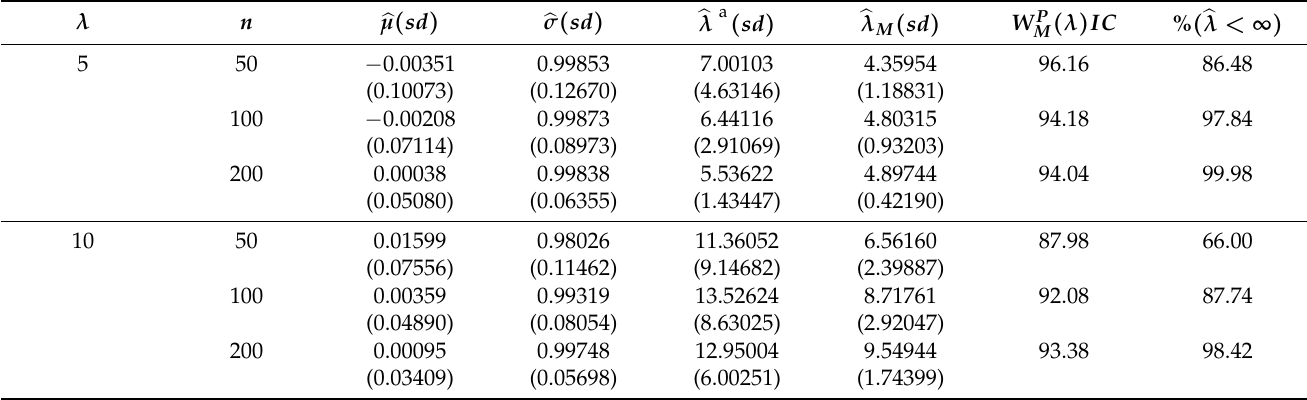
Table 2. Results are based on 5000 samples simulated from the MSN ( 0,1, λ )